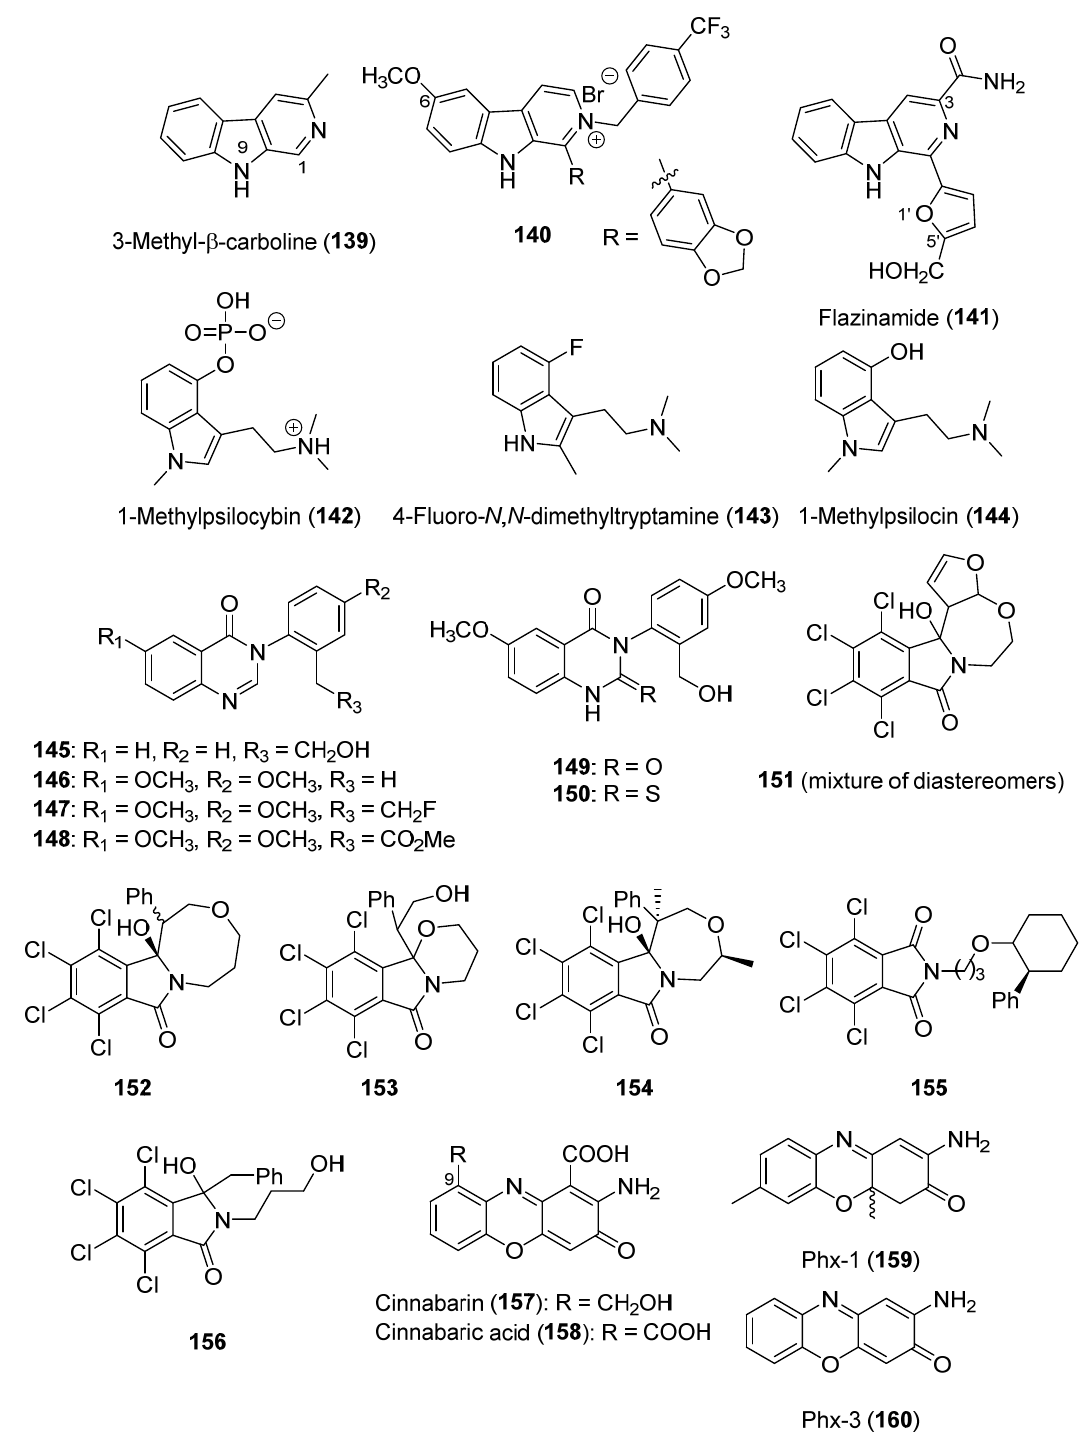
Figure 9. Related compounds and some synthetic structural analogs employed in SAR studies of the reviewed alkaloids. reviewed alkaloids 139 – 160